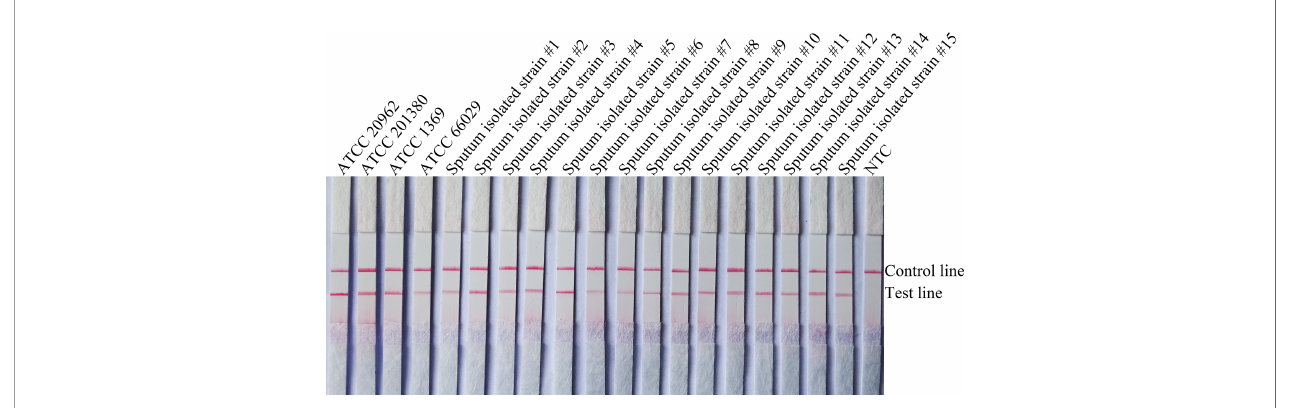
FIGURE 4 | Validation of the speci fi city of primer pair F5/P/R1B against C . tropicalis . #1 – 15 refers to fi fteen isolates of C . tropicalis from clinical samples, and NTC indicates no template control. The positions of the test and control lines are marked on the right side of the bar graph. Reactions were performed at 39°C for 20 min. Images are representative of three